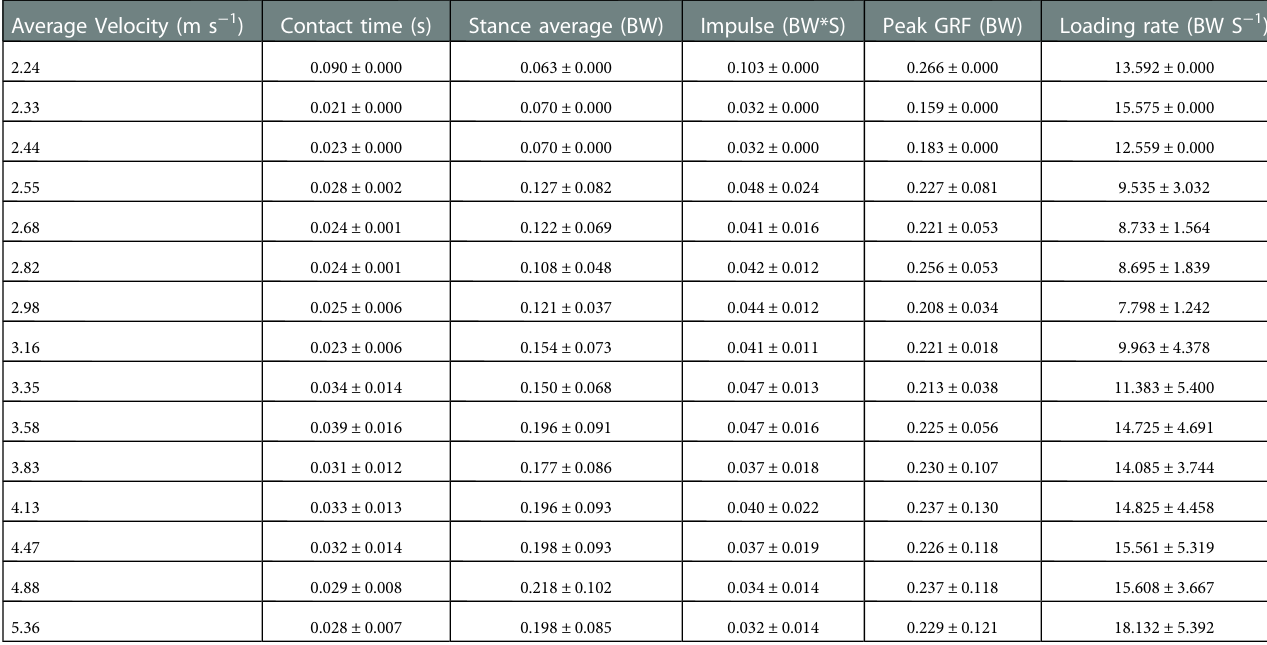
TABLE 5 LSTM estimated spatial-temporal and kinetic variables root mean square